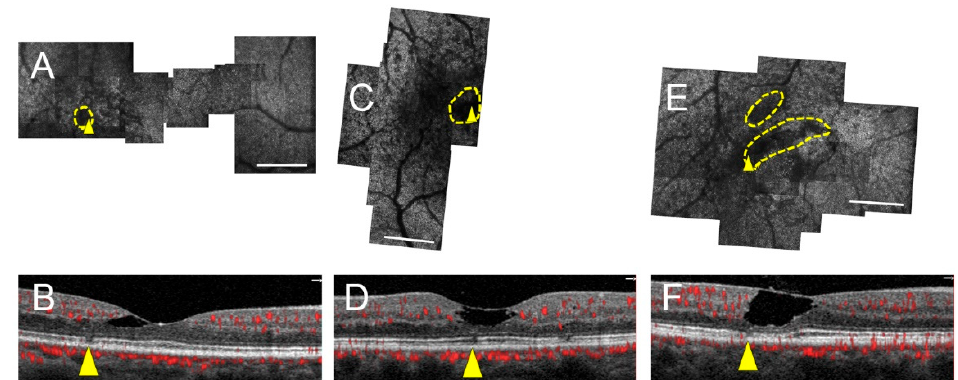
Figure 5. Photoreceptor lesions correspond to disrupted EZ in three stage 2 MacTel eyes. Subjects 5 (right eye; A , B ), 6 (left eye; C , D ), and 7 (right eye; E , F ). AOSLO montages with outlined, yellow lesion and yellow arrowhead ( A , C , E ) corresponding to accompanying SD-OCT cross-sections ( B , D , F ). AOSLO lesions extend beyond areas of EZ loss (yellow arrowhead) on SD-OCT and partially correspond to the intact EZ. Scale bars = 500 μ m.